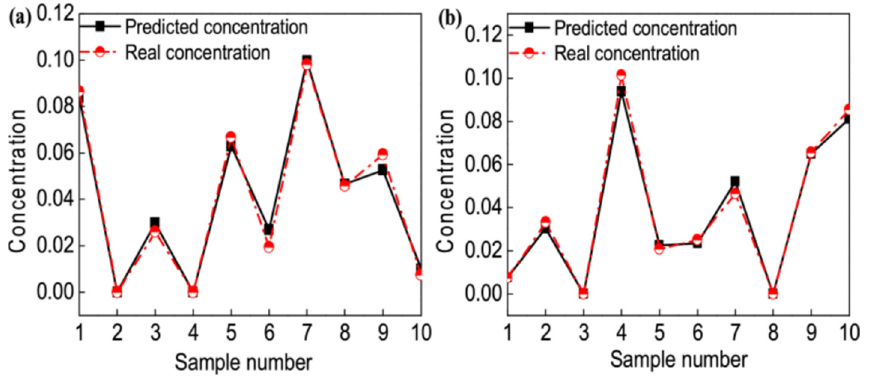
Figure 19. Actual and predicted concentrations of the two target components in mixtures: ( a ) NAA and ( b ) NE [190].